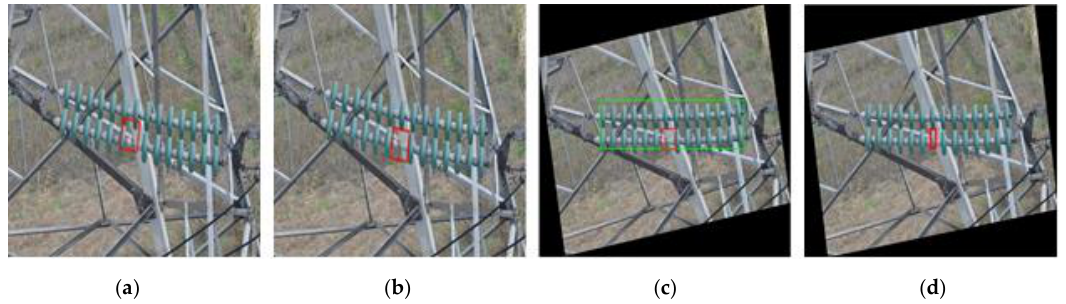
Figure 9. Comparison for insulators under the individual condition: (a) Literature [17] method; (b) Literature [19] method; (c) Literature [23] method; ( d ) Proposed method.